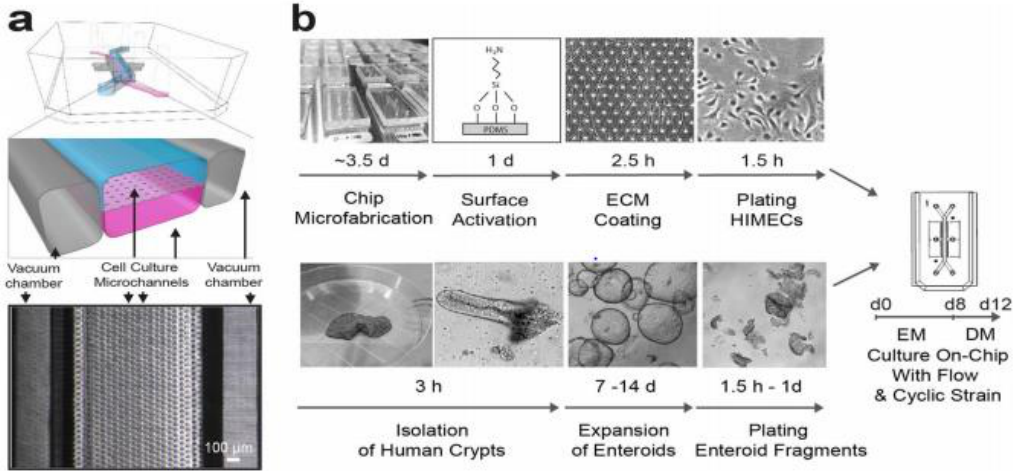
Figure 2. Primary human intestine chip manufacturing outline. ( a ) A cross-sectional view from the top of the chip and a phase contrast micrograph of the chip viewed from the bottom showing the upper (epithelial; blue) and lower (microvascular; pink) cell culture microchannels separated by a porous, Extracellular Matrix (ECM)-coated, Polydimethylsiloxane (PDMS) membrane sandwiched in-between. ( b ) An outline in developing microfuidic co-cultures of primary human intestinal epithelium and intestinal microvascular endothelium in the intestine chip. Source: Kasendra et al. [60] ( Scientific Reports , Springer Nature) Licensed under CC BY 4.0.